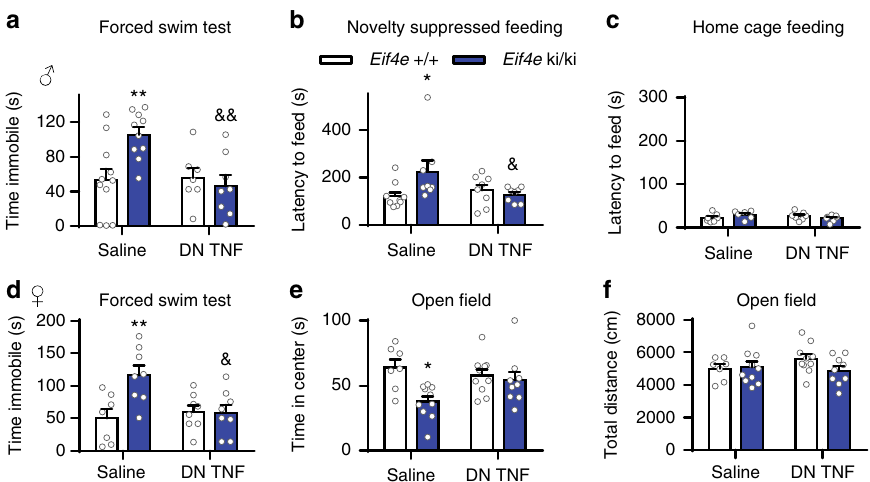
Fig. 6 TNF α causes behavioral impairments in Eif4e ki/ki mice. a wild-type and Eif4e ki/ki mice were administered (ICV) a dominant negative mutant version of TNF α (DN TNF) or vehicle for 12 days (via an osmotic pump connected to a guide cannula). Male mice were then evaluated in the FST ( n = 11 Eif4e + / + Saline, n = 7 Eif4e + / + DN TNF, n = 10 Eif4e ki/ki Saline, n = 8 Eif4e ki/ki DN TNF). b Mice were also tested in the novelty suppressed feeding task ( n = 10 Eif4e + / + Saline, n = 8 Eif4e + / + DN TNF, n = 8 Eif4e ki/ki Saline, n = 8 Eif4e ki/ki DN TNF). c Latency to feed in their home cage was also measured. d Female mice also administered with vehicle or DN TNF (ICV) were evaluated in the FST ( n = 7 Eif4e + / + Saline, n = 8 Eif4e + / + DN TNF, n = 8 Eif4e ki/ki Saline, n = 8 Eif4e ki/ki DN TNF). e Female mice exploratory behavior was also measured in the center of an open fi eld (OF) ( n = 7 Eif4e + / + Saline, n = 10 Eif4e + / + DN TNF, n = 10 Eif4e ki/ki Saline, n = 9 Eif4e ki/ki DN TNF). f Their locomotion in the OF was also measured. * p < 0.05, ** p < 0.01, *** p <